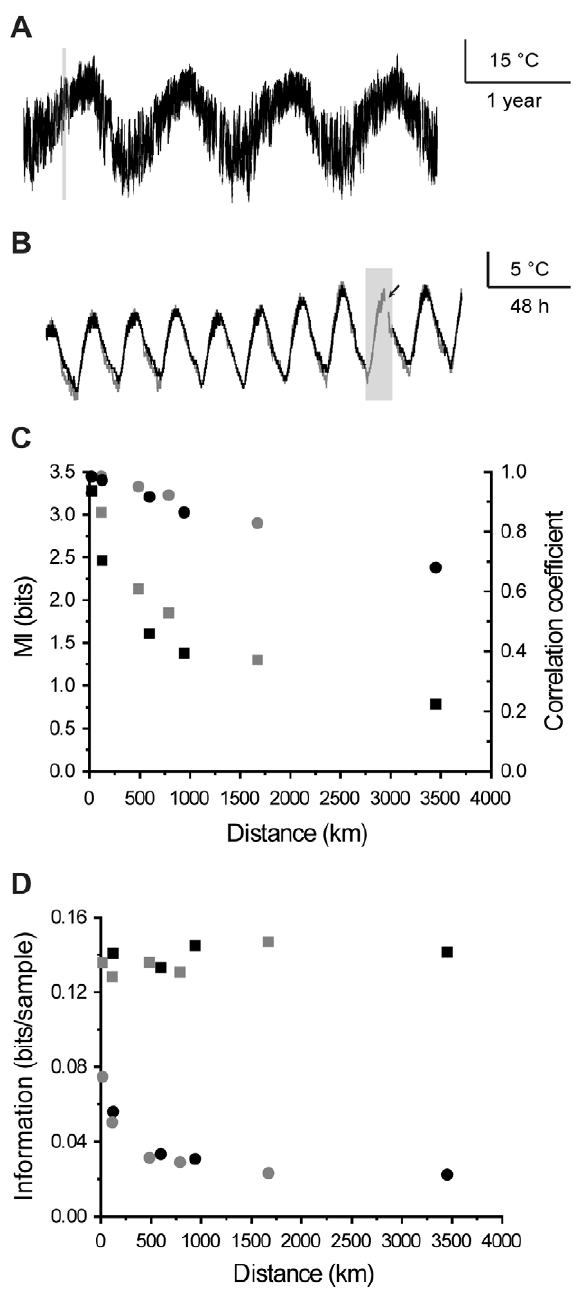
Figure 4. Information theoretical analysis of the climate data. A , 4 years of surface temperature data from two nearby weather stations in Dallas, Texas. B , 10 day enlargement of the section indicated with the grey bar in A . Data points are missing on the highlighted section on either one or both of the traces (indicated by arrow). C , MI (squares) and linear correlation coefficients (circles) as a function of distance between the observation points. Latitudinal (black) and longitudinal (grey) data sets span across the continent orthogonally. D , Information rate (squares) and capacity (circles) as a function of distance. The color coding is as in C .